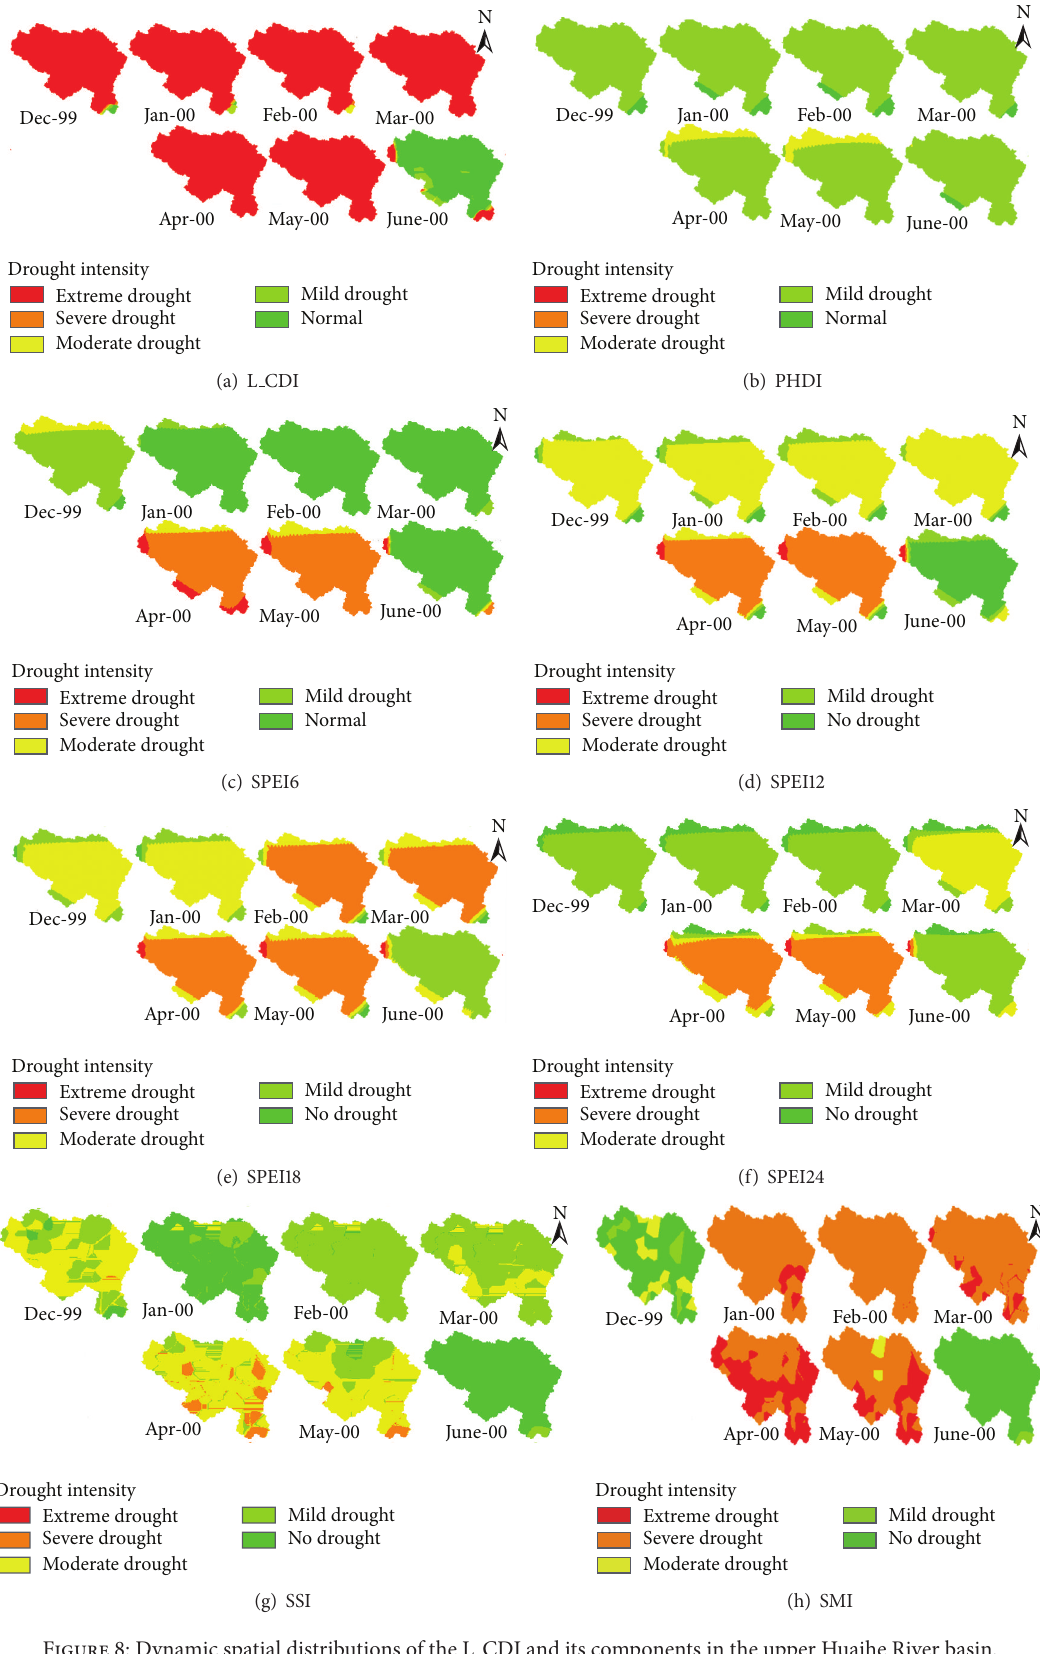
Figure 8: Dynamic spatial distributions of the L CDI and its components in the upper Huaihe River